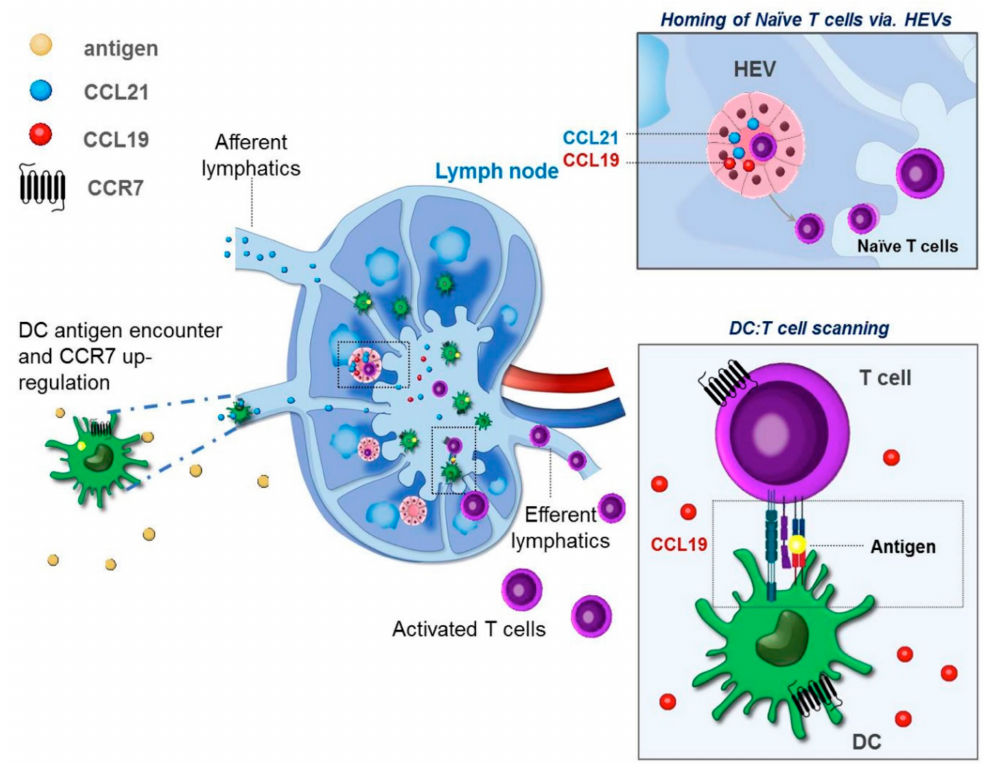
Figure 2. Based on their differential tissue expression and signaling properties, the chemokines CCL19 and CCL21 exert different functions in vivo. CCL21 is believed to be the major lymph node (LN)-homing chemokine, directing the LN localization of activated CCR7 + dendritic cells (DCs) through afferent lymphatics. As both CCL19 and CCL21 are present in high endothelial venules (HEVs) and T cells enter the LN through the HEVs, both CCL19 and CCL21 appear to be important for directing the localization of CCR7 + T cell subsets (naïve, memory, and Treg) to the LN. CCL19 secreted by active DCs in the LN partakes in the subsequent scanning and DC–T cell priming process, directing T cells to interact with the DCs. The rapid internalization of CCR7 occurring upon receptor engagement with CCL19 allows for a swift DC–T cell interaction and allowing for the scanning process to